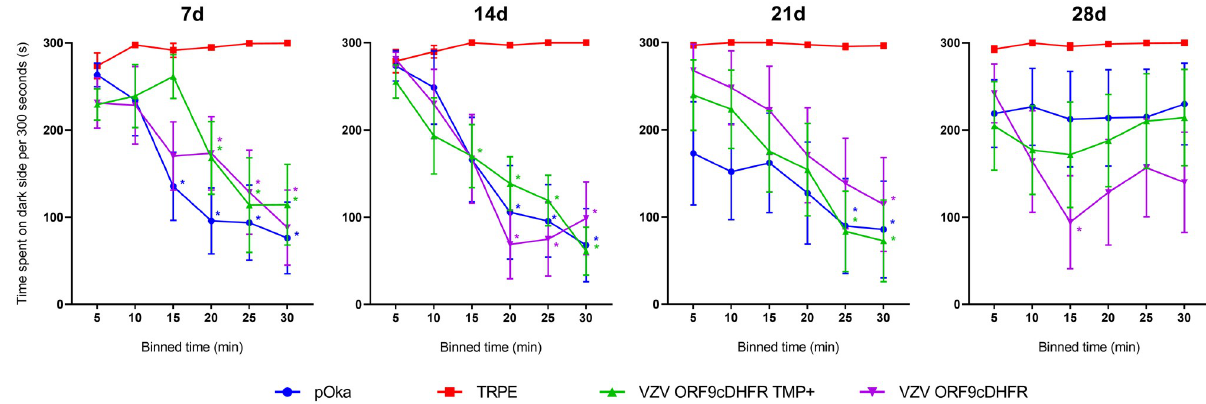
Fig 8. Affective pain develops in rat whisker pad following inoculation with replication conditional VZV ORF9cDHFR under both growth- permissive and nonpermissive conditions. Male Sprague-Dawley rats (n = 7/group) received inoculation into the whisker pad of 2x10 5 PFU TRPE- associated pOka (blue circle), VZV ORF9cDHFR in buffer with 500 nM TMP (green triangle) or without TMP (purple triangle), or uninfected TRPE cell equivalent without TMP (red square). Hypersensitivity was measured at the times indicated by days (d) post-infection above each graph using a PEAP method detailed in methods. Time spent in the dark side (y-axis) of the enclosures is shown after repeated stimulation with a 60g (5.88) von Frey hair every 15 seconds, assessed over 5-min bin periods for a total of 30 min (x-axis). The side of the face stimulated depended on the position of the rat’s head, with facial stimulation at the inoculated side if its head is in the dark side of the enclosure, and stimulation of the uninoculated side of the face if in the light side of the enclosure. Error bars: SEM. Statistics: Two-way ANOVA with Bonferroni multiple comparison to TRPE negative control where � p < .05 and color coded by